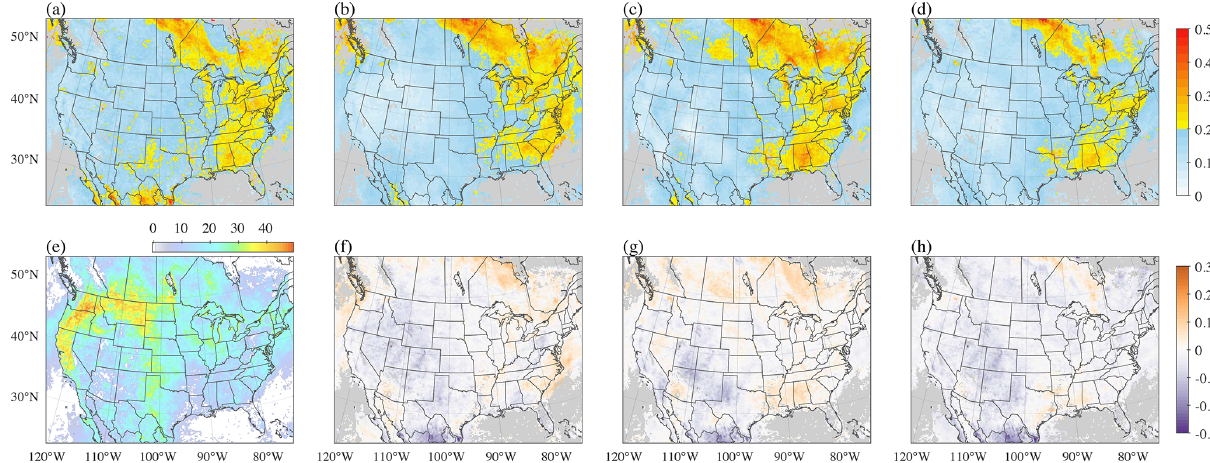
Figure 8. Aerosol optical depth at 550nm from (a) MODIS MAIAC C6.1, (b) WRF-VFEI, (c) CAMS reanalysis, and (d) MERRA-2 reanalysis averaged between 22 July and 10 August 2019. (e) Number of observations per grid point weighted in the final average for each dataset. Panels (f) – (h) show the mean monthly bias from each dataset with respect to MODIS MAIAC C6.1. Gray areas represent grid points with no observations during the period.